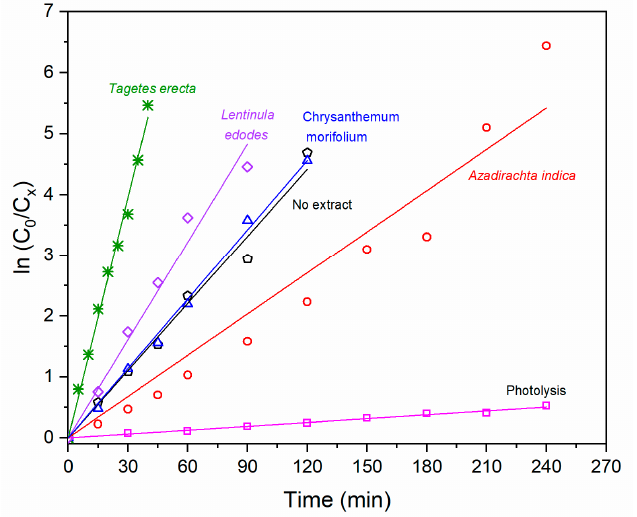
Figure 10. ln( C 0 / C x ) as a function of sunlight exposure time of MB and varying catalyst .